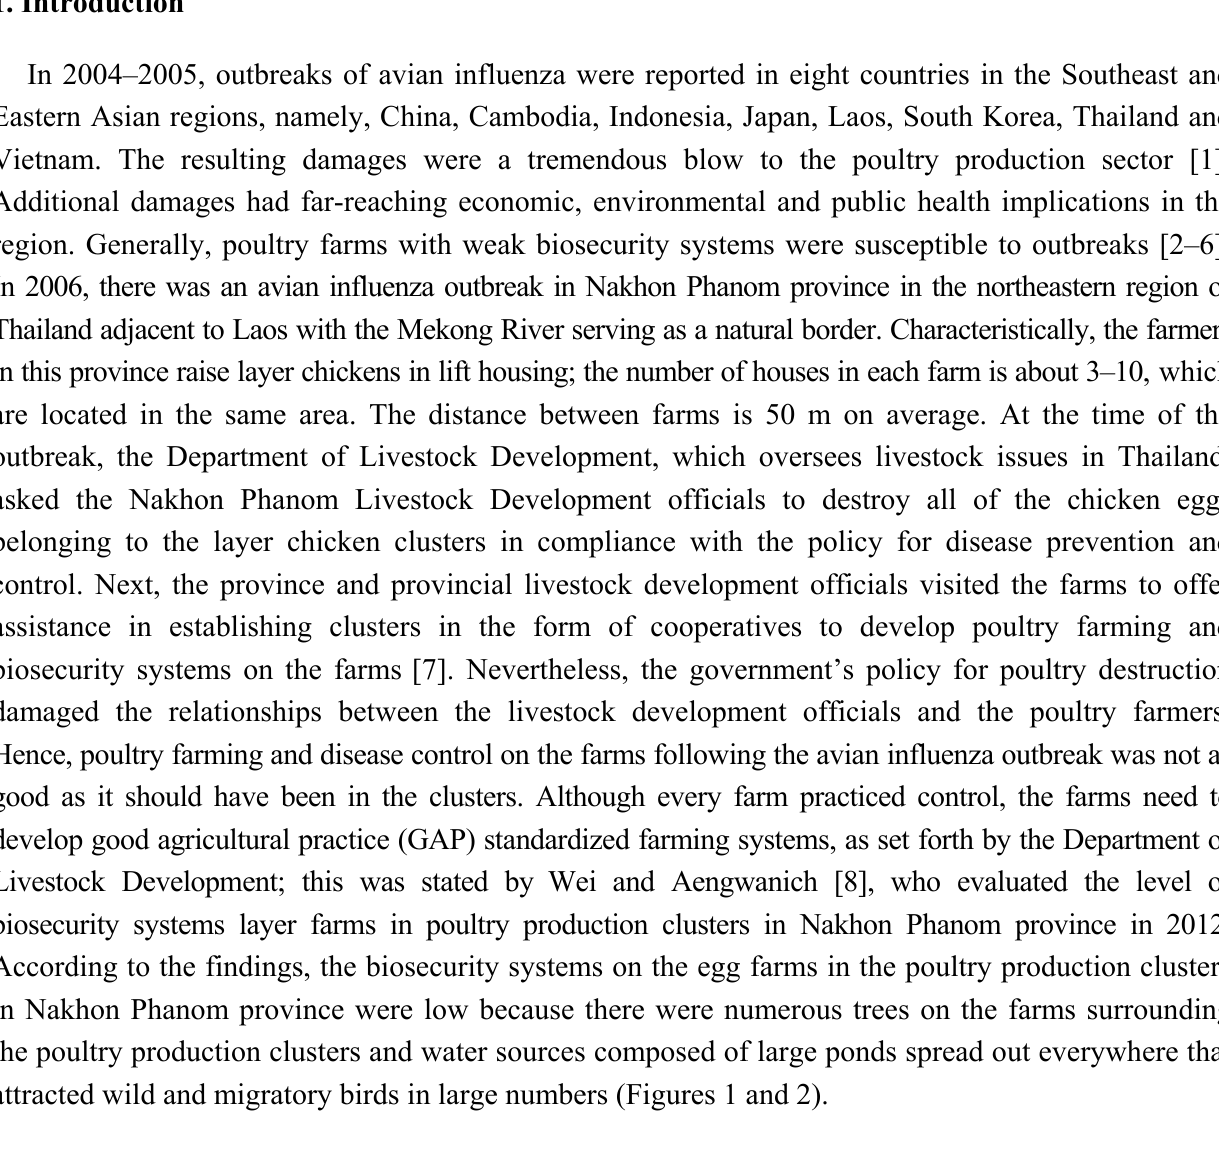
Figure 1. The ecosystems in the communities of poultry production clusters in Nakhon Phanom province, which are composed of large ponds (P) as community water sources and trees (T) surrounding the poultry